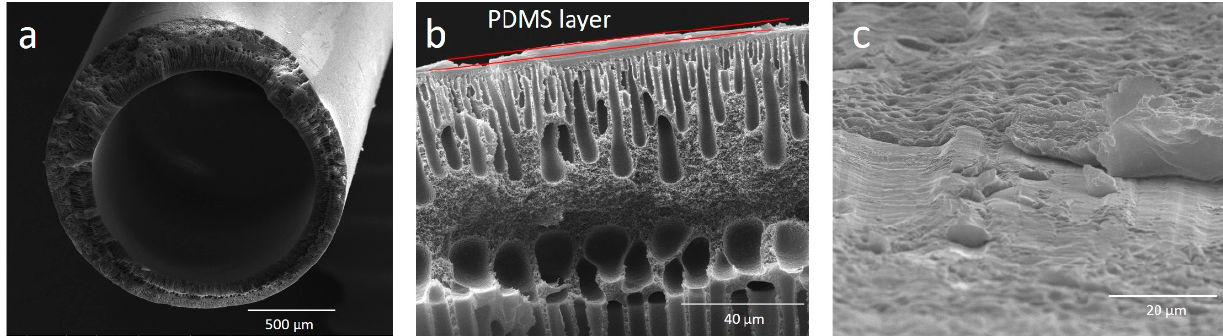
Figure 2. SEM pictures of polydimethysiloxane (PDMS)/PEI membrane prepared from 15 wt% PDMS solution at 10 min coating time: ( a ) overall cross-section, ( b ) enlarged cross-section, and ( c ) outer PDMS coating layer.